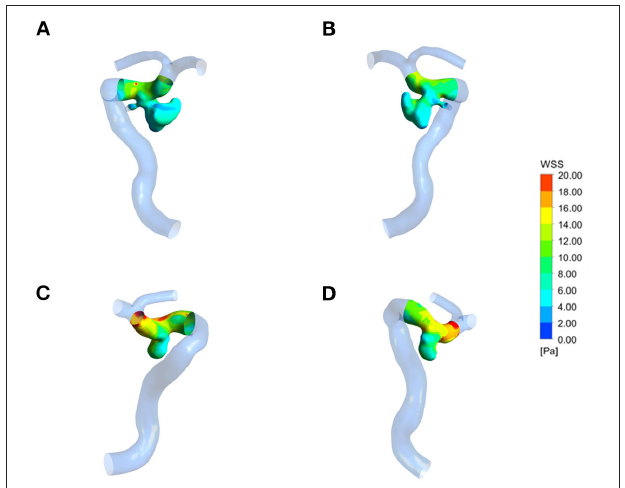
FIGURE 2 | Wall shear stress (WSS) distribution of a representative ruptured mirror PComAA. (A,B) Two sides of WSS distribution of the ruptured left PComAA. (C,D) Two sides of WSS distribution of unruptured right PComAA. The WSS of ruptured PComAA was significantly lower than that of unruptured PComAA.